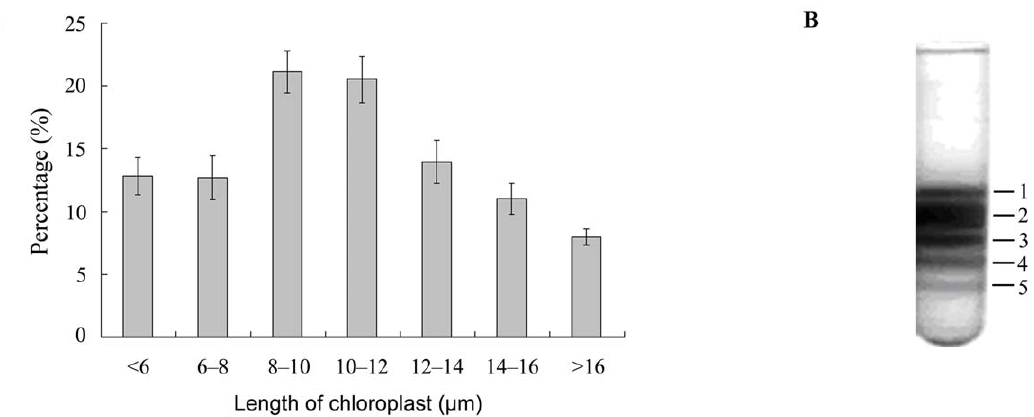
Figure 2. Dimensions of chloroplasts in the B.hypnoides thallus. (A) The size distribution of chloroplasts in Bryopsis hypnoides thallus as inferred by optical microscope (ZEISS HBO 50, Germany). Ten fields of vision ( 6 200) were selected randomly and all of the chloroplasts with different sizes were determined with an eyepiece micrometer. (B) The chloroplasts separated by sucrose density gradient centrifugation from the wild B. hypnoides . Numbers indicate the five discrete bands.